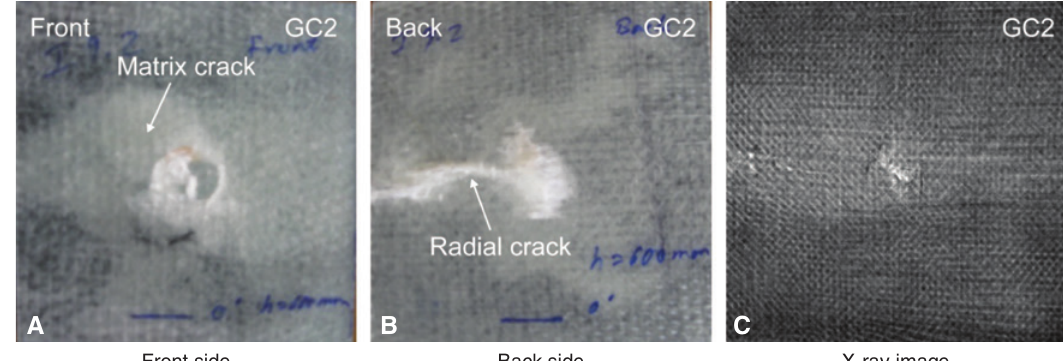
Figure 7: Photographs of impacted specimen GC2.